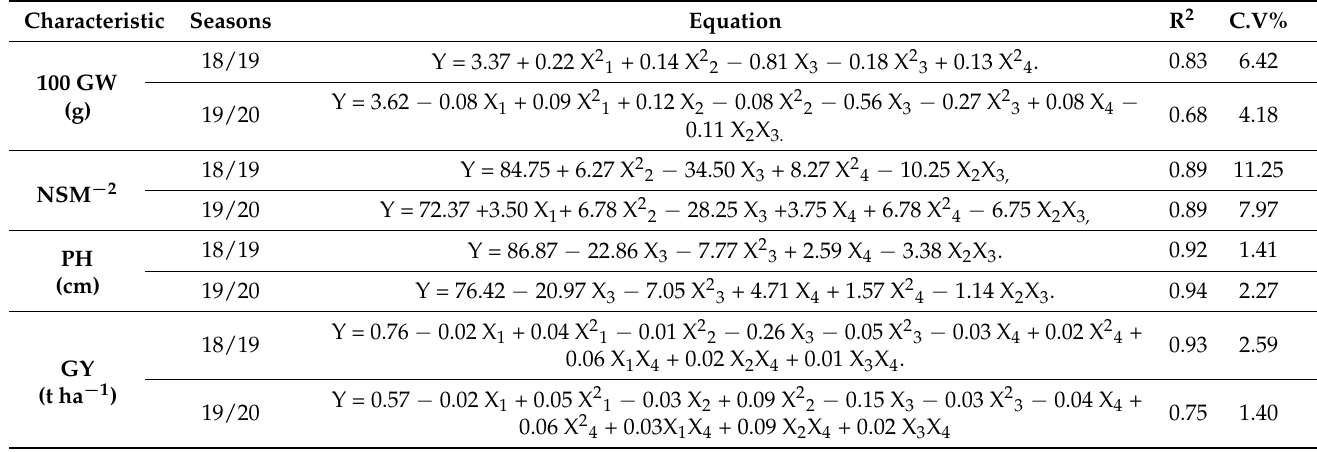
Figure 6. Response surface for degraded neutral detergent fiber as affected by PF and AA at the central levels of AC and HA in 2019/20. central levels of AC and HA in 2019/20. Table 8. The regression equation describing the relationship between 100-grain weight (100 GW), number of spikes m − 2 (NSM − 2 ), plant height (PH) and grain yield (GY) and the investigated factors in 2018/19 and